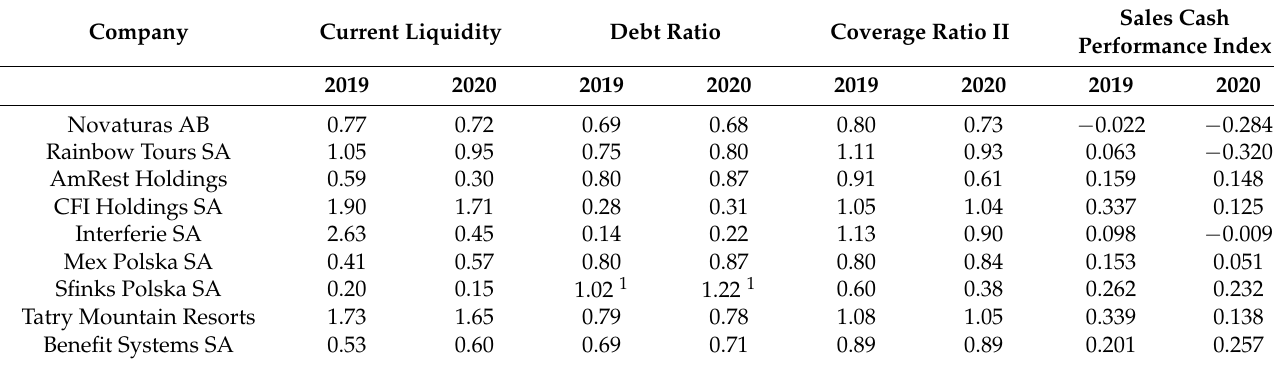
Table 4. The value of the selected financial indicators for surveyed